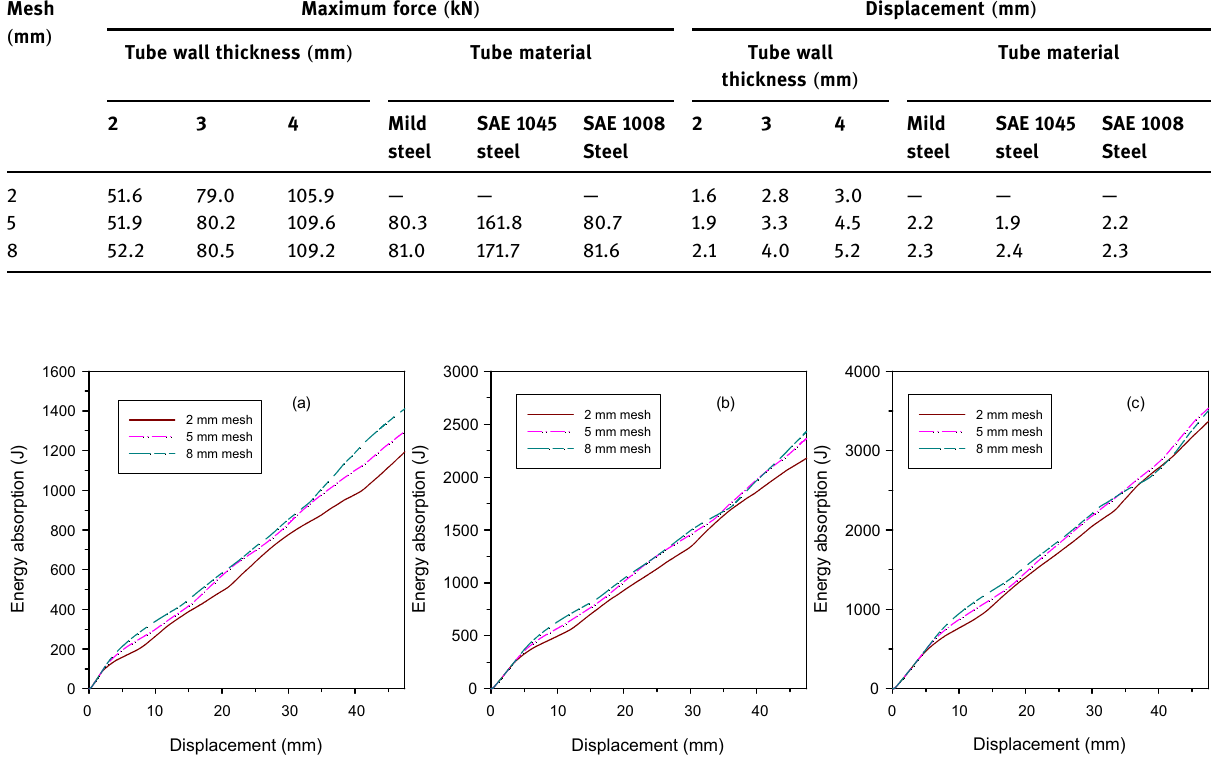
Table 3: Maximum force value of the tube under axial loading dependent on the mesh size Mesh ( mm )